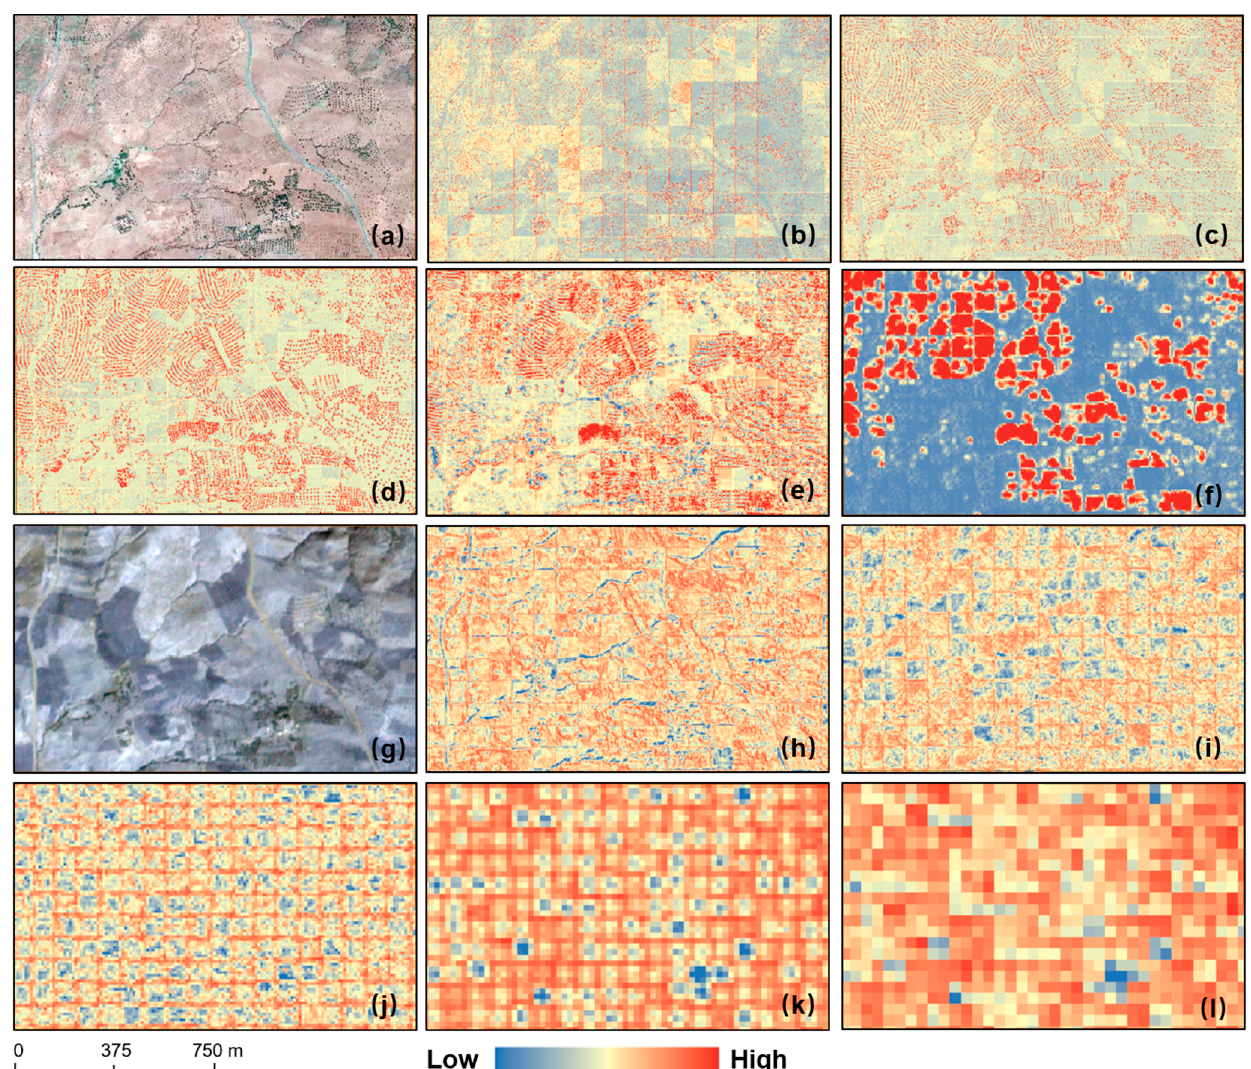
Figure 12. Feature representations for the olive orchard in grid 4, sub-humid site 9. ( a , g ) RGB imagery from DG and Planet; ( b – f ) feature representations of convolutional layer one to five for DG imagery; ( h – l ) feature representations of convolutional layer one to five for Planet imagery.